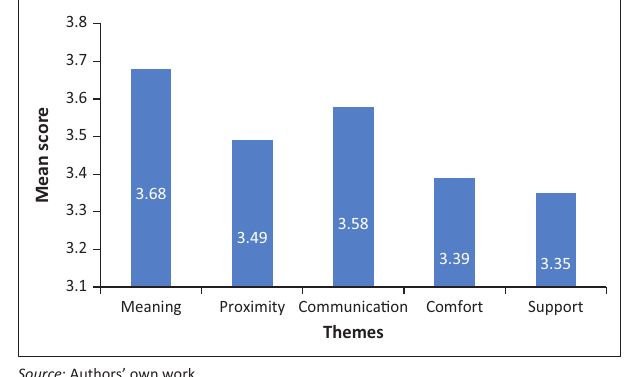
FIGURE 1: Overview of results for themes of CCFNI-1 (level of